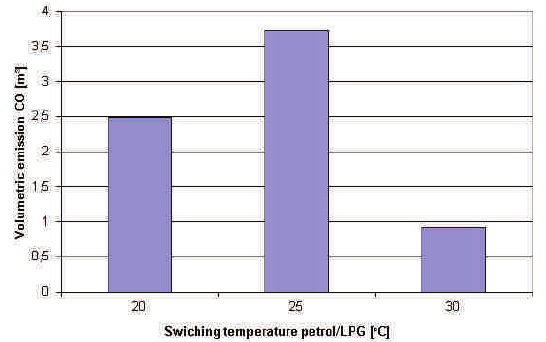
Fig. 6. Cumulative CO emissions in the fume gases from cold start to fuel switching moment